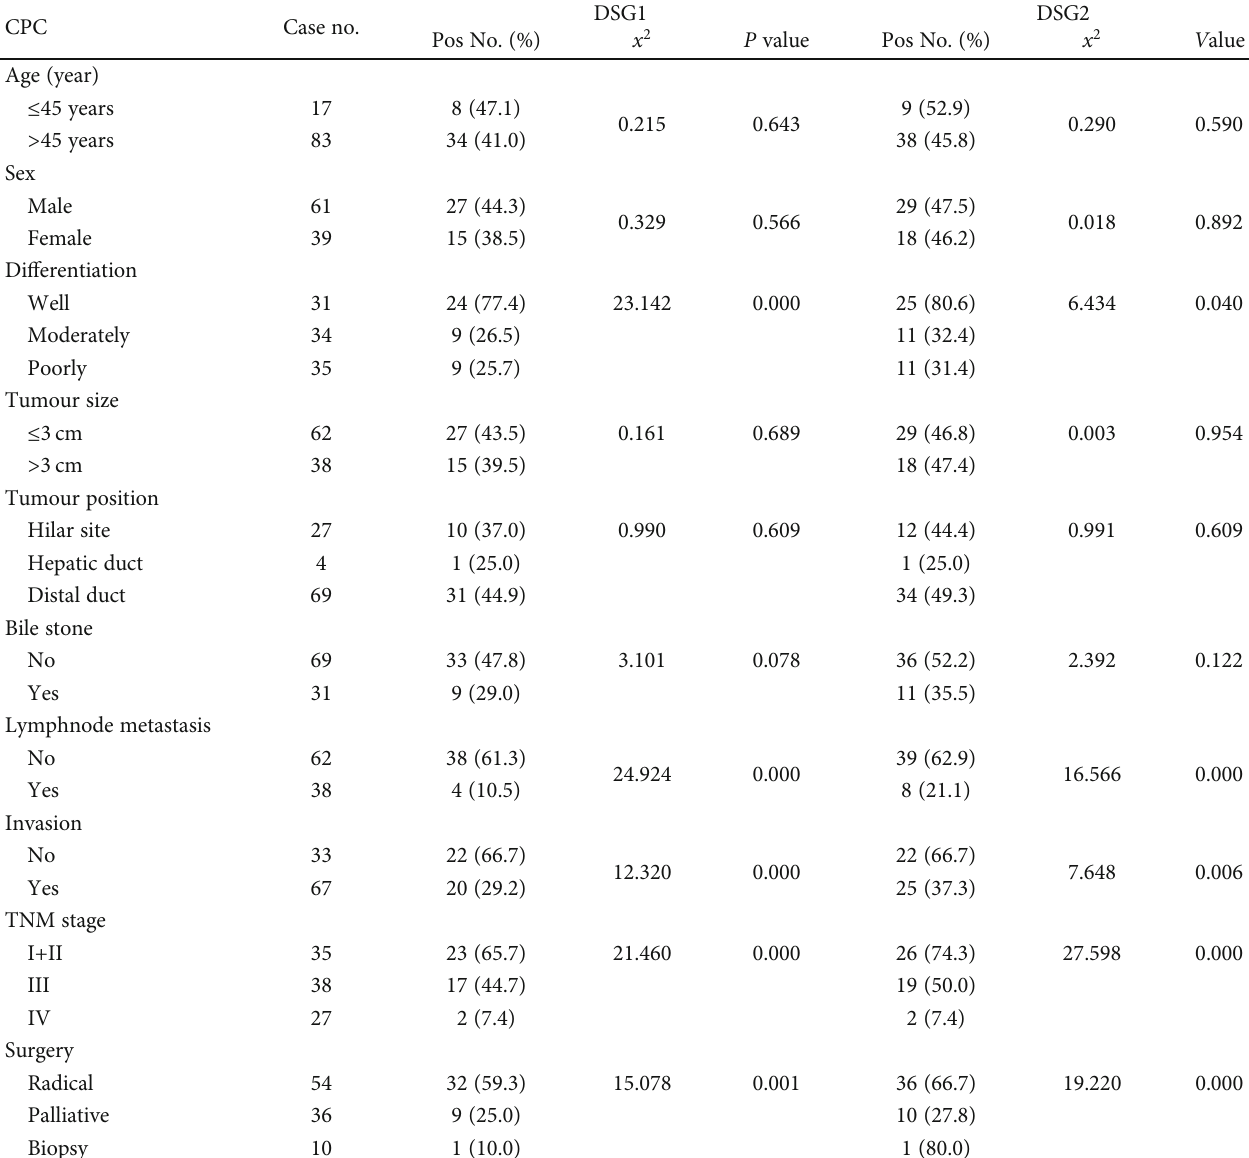
Table 1: Correlations of DSG1 and DSG2 protein expression with the clinicopathological characteristics of EHCC. CPC Case no.